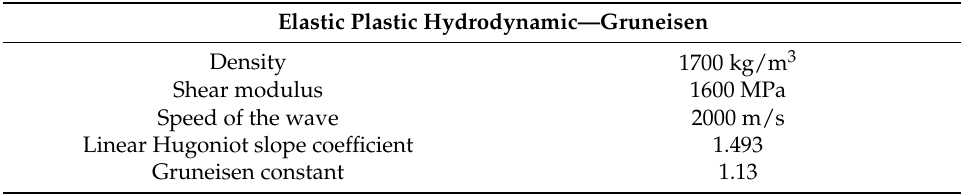
Table 2. Material properties of the CA7049 epoxy